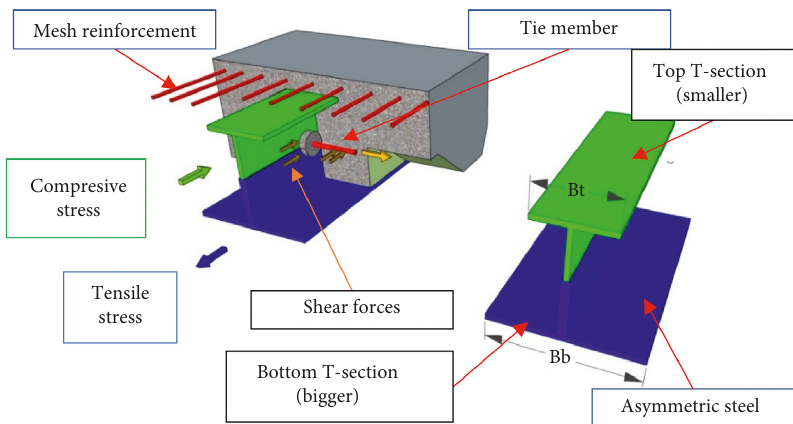
Figure 4: Composite shallow cellular floor beam system.